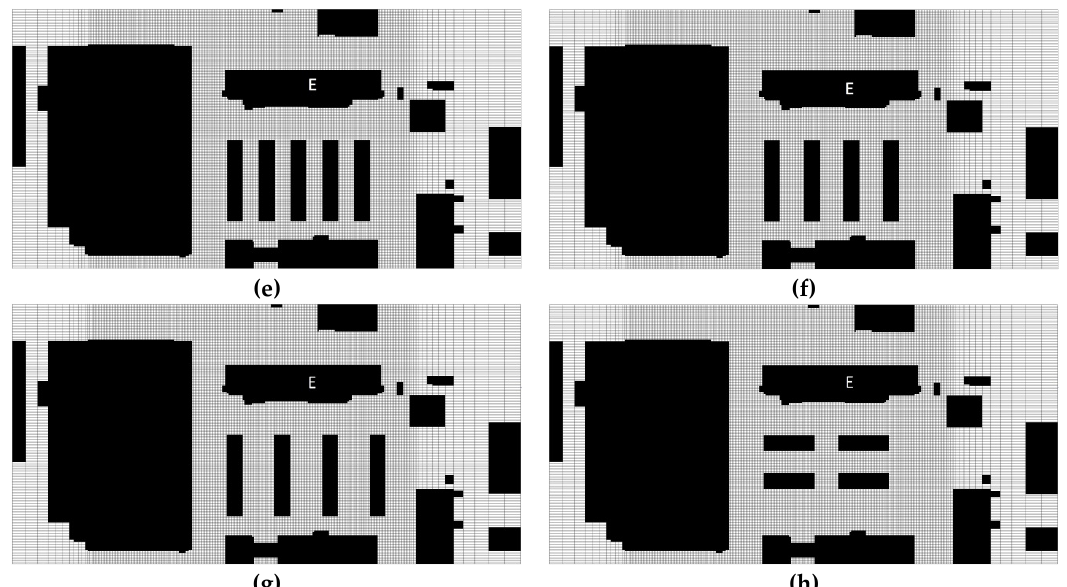
Figure 4. Detail of the MISKAM model domain (horizontal cross section at street level) with horizontal shape of the buildings (black structures, ENERGYbase is indicated by white E) for ( a ) scenario A, ( b ) scenario B, ( c ) scenario C, ( d ) scenario D and E, ( e ) scenario F, ( f ) scenario G, ( g ) scenario H and ( h ) scenarios I and J (see text for explanation). Length scale is depicted in Figure 4a.